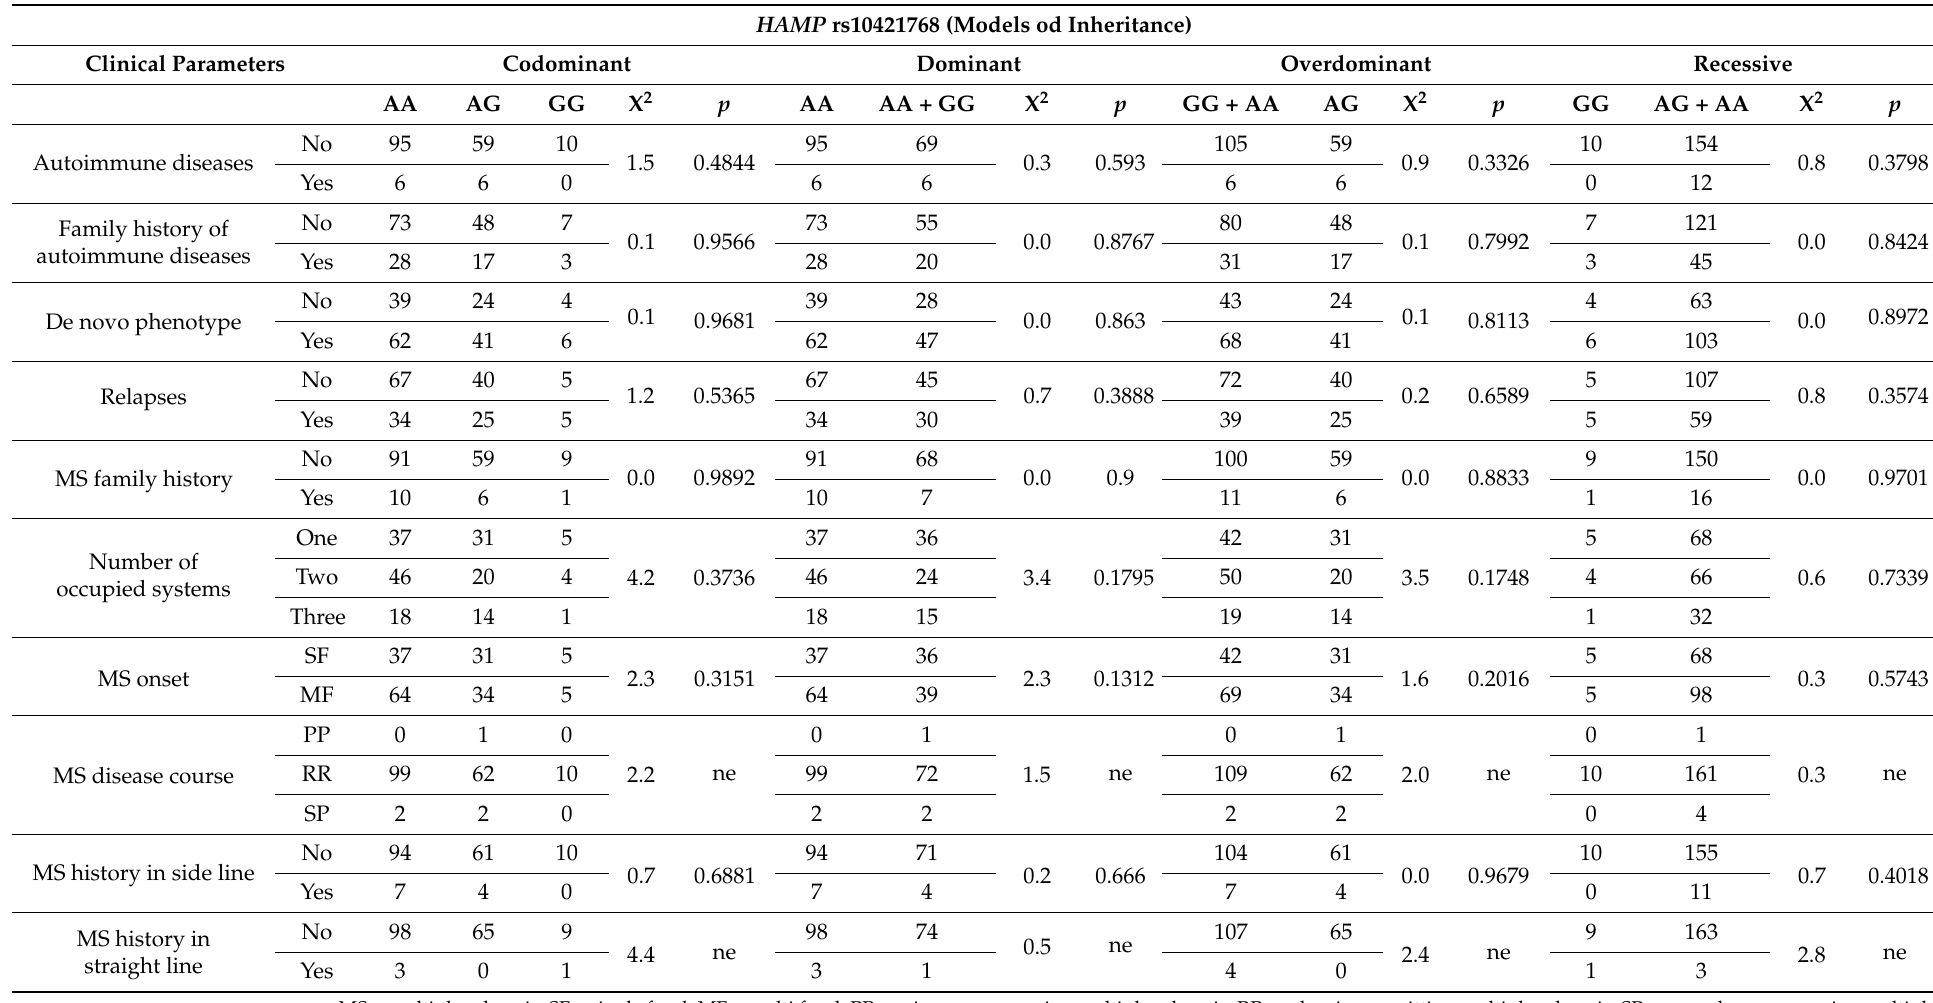
Table 8. Analysis of the relationship between the rs10421768 HAMP polymorphism and selected clinical parameters. HAMP rs10421768 (Models od